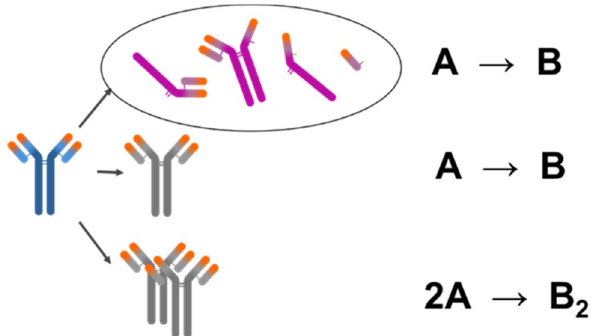
Figure 1. Simplified scheme of protein degradation and aggregation pathways. Top scheme: fragmentation, middle scheme: chemical modifications, bottom scheme: aggregation. Figure made in PowerPoint 2016 (Microsoft, Redmond, WA,